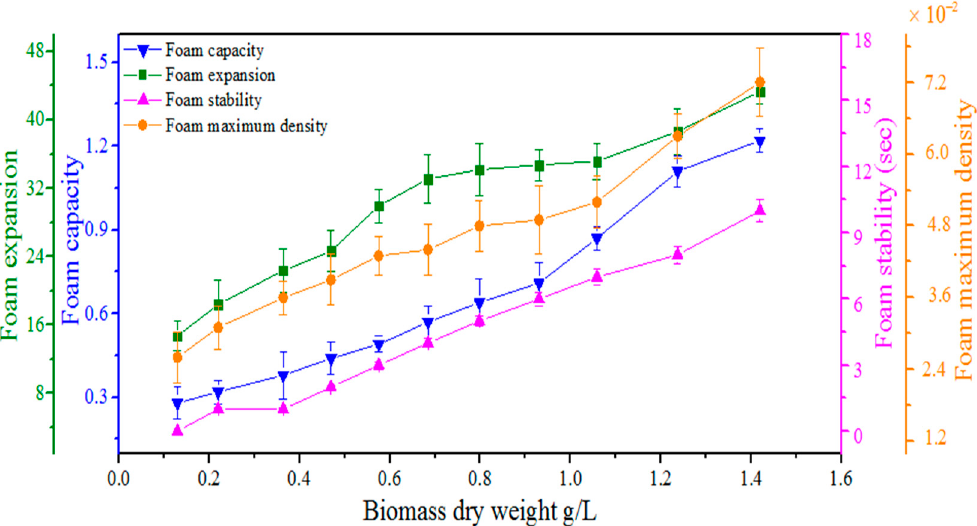
Figure 6. The dependence of foaming characteristics, including foam capacity, foam expansion, foam stability, and foam maximum density, on the microalgal biomass dry weight produced for 4 days. Note: Foam Stability = Half-life of foam from generation to disappear, Foam capacity = Ratio of foam volume to gas volume, Foam expansion = Ratio of foam volume to reduced liquid volume from initial to final condition, and Foam maximum density = Ratio of the difference between the initial liquid volume and the final liquid volume with the final foam volume. Note: Each data point is an average of three replicates with a standard deviation, n = 3.